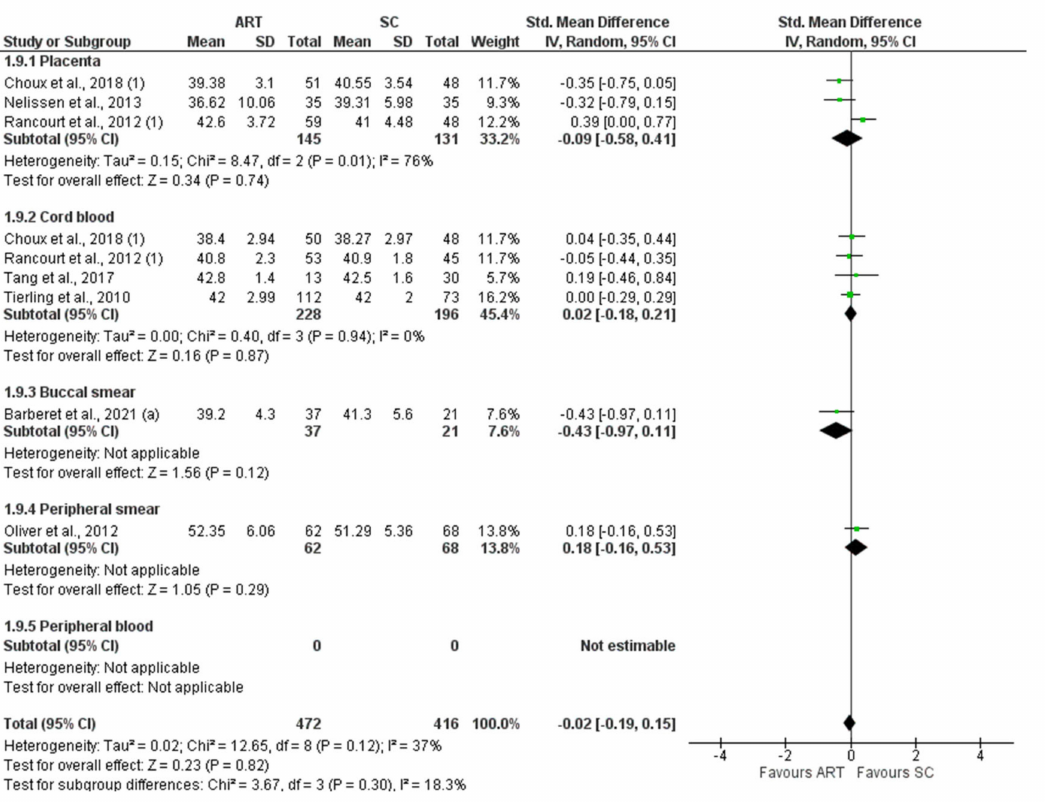
Figure 6. Methylation levels of SNRPN [25,33,52,55,59,65,66]. ART, assisted reproductive technique; SC, spontaneous